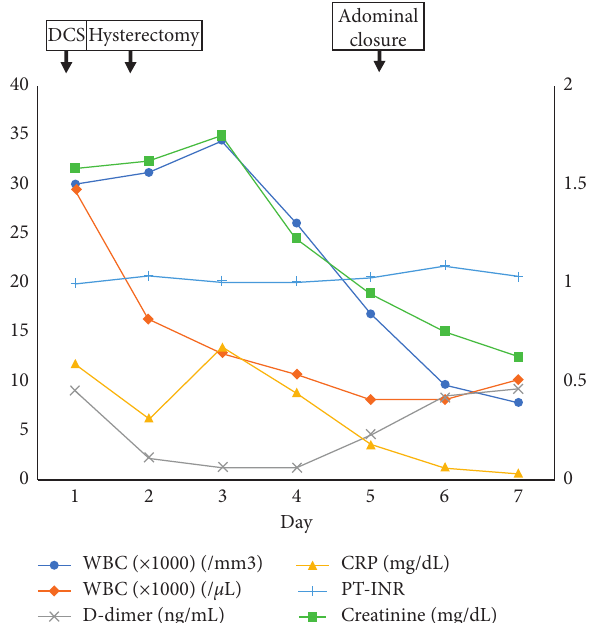
Figure 3: Changes in laboratory data after admission. Inflam- matory parameters, renal function, and clotting ability of blood were generally stable within a week. DCS, damage control surgery; WBC, white blood cell; Plt, platelet; CRP, C-reactive protein.